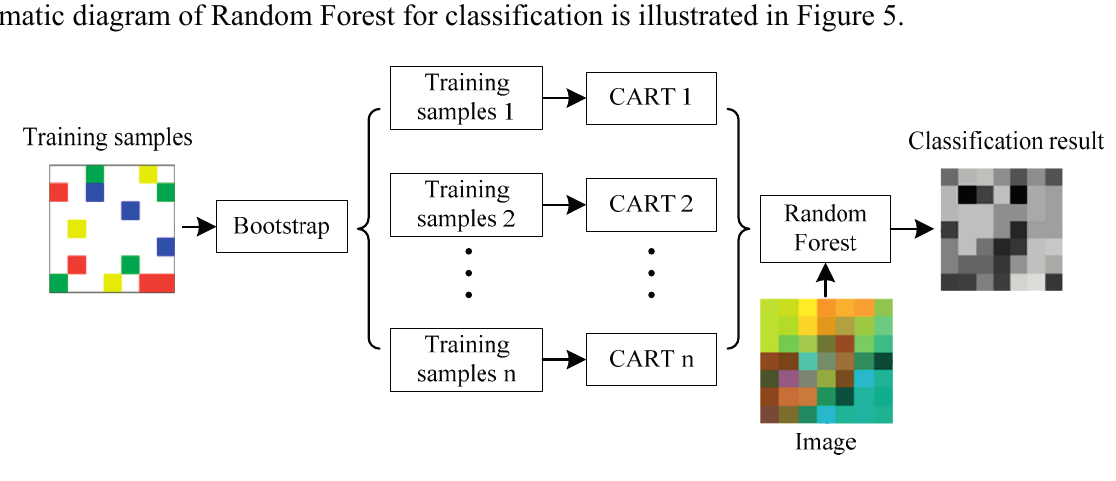
Figure 5. Schematic diagram of Random Forest for image